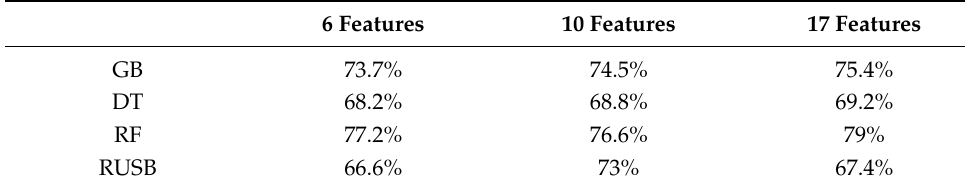
Table 11. Accuracy of the ML algorithms to predict the outcome Severity.